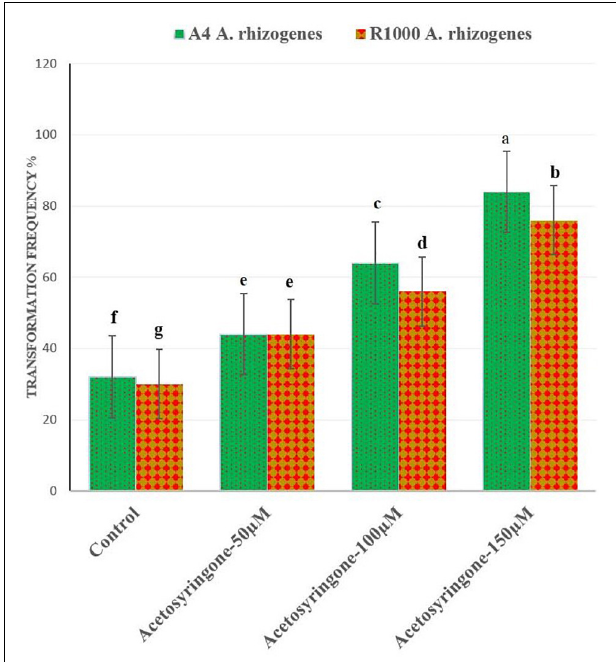
FIGURE 3 | Effect of different concentrations of acetosyringone (AS) on A. rhizogenes (A 4 and R 1000 strains) transformed frequency (%) of hairy roots inductions in A. vulgaris .